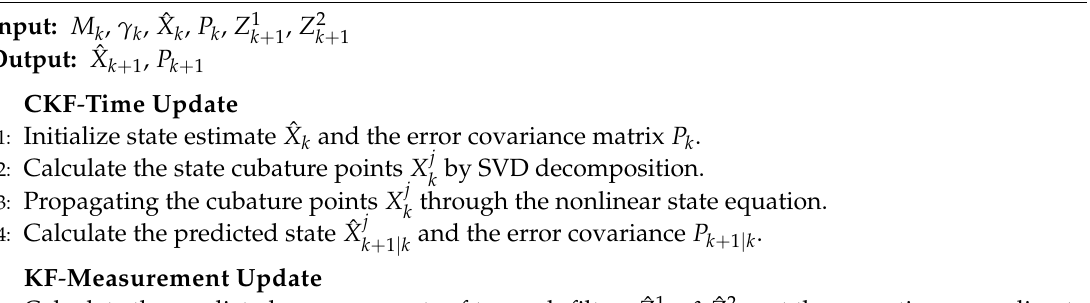
Algorithm 1 A Cycle of SVD-FDCKF Algorithm to Estimate System